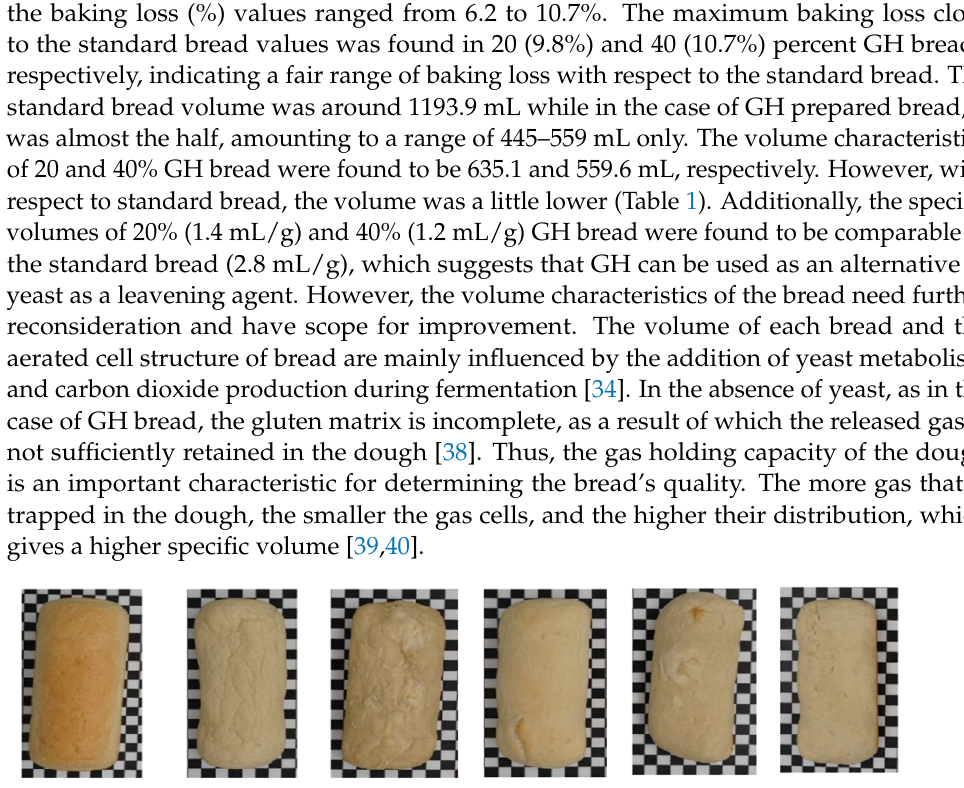
Table 1. The characteristics of standard bread versus GH bread.